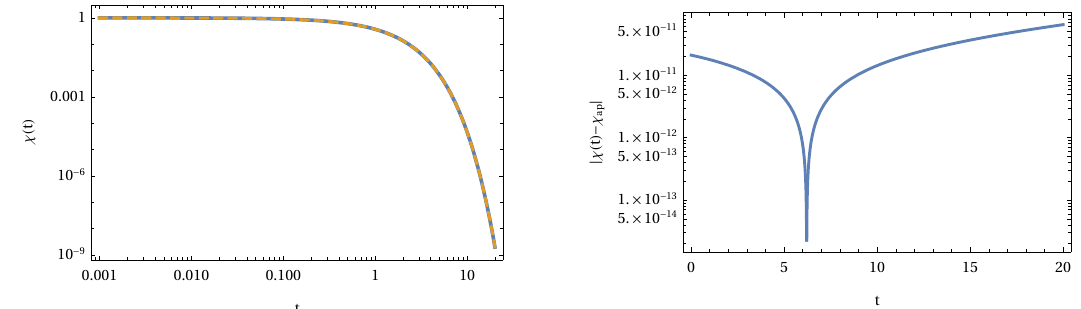
Figure 3. Solution of the Debye relaxation Equation (84) generated by the inverse Laplace transform of ˜ G ( s ) . The left panel also includes the exact solution of the relaxation equation given by χ ( t ) = χ 0 exp ( − ( t / τ )) (dashed) and the approximation (solid line). The right panel shows the local error of the exact solution and the approximation. The number of approximation points used in the calculation was m = 2 N + 1 = 35. The parameters to generate the plot are χ 0 = 1 and τ = 1.